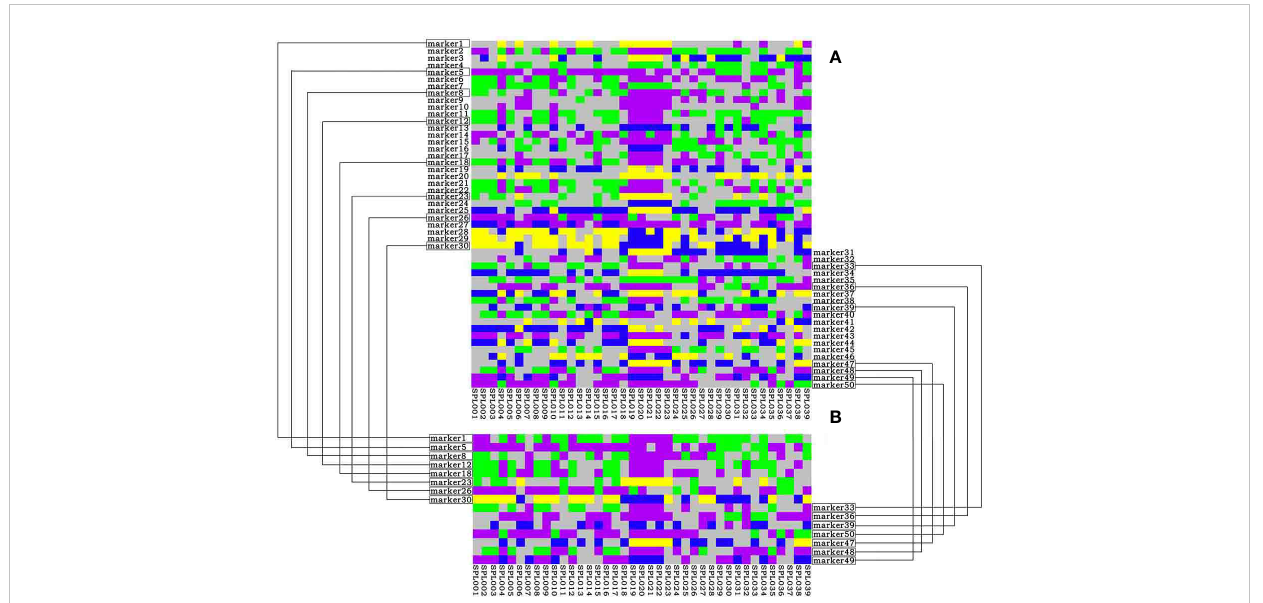
FIGURE 5 DNA fi ngerprinting of 39 Lonicera samples. (A) DNA fi ngerprint is composed of 50 single nucleotide polymorphisms (SNPs). (B) DNA fi ngerprint composed of 15 SNPs. Homozygous genotypes C/C, A/A, T/T, and G/G are represented by yellow, green, blue, and purple, respectively; heterozygous genotypes are represented by gray; deletion genotypes are represented by